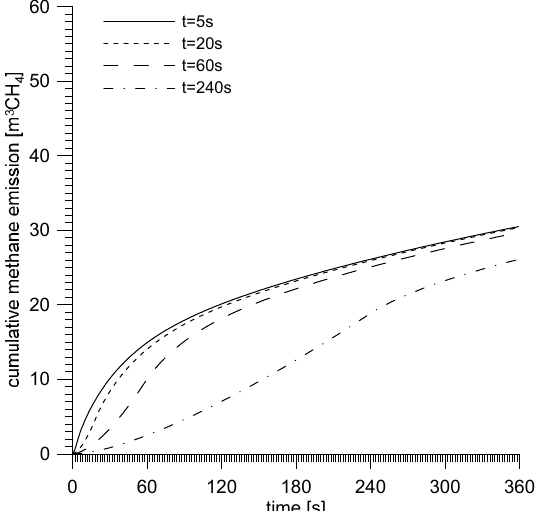
Figure 21. Model cumulative emissions of methane determined based on the plane sheet model during Budryk outburst.